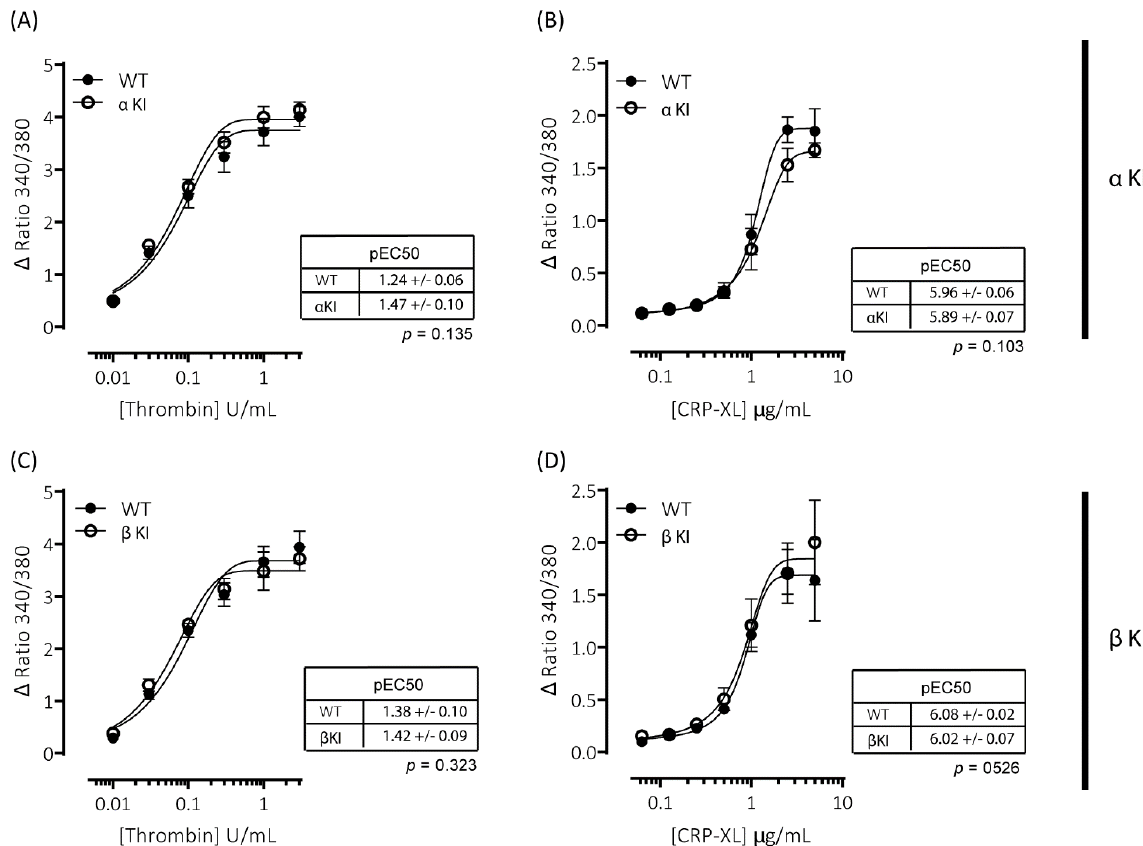
Figure 4. Intracellular Ca 2+ signalling is unaltered in platelets expressing phosphorylation-resistant GSK3 α or GSK3 β . Changes in intracellular [Ca 2+ ] were determined by loading platelets with the calcium indicator Fura-PE3 AM and monitoring fluorescence at 340/380 nm on an Infinite ® 200 PRO multimode reader (TECAN, Reading, UK). Platelets from α KI mice had no significant alterations in calcium mobilisation in response to ( A ) thrombin ( n = 4) or ( B ) CRP-XL ( n = 6). Platelets from β KI mice had no significant alterations in calcium mobilisation in response to ( C ) thrombin ( n = 3) or ( D ) CRP-XL ( n = 4). Data are expressed as the change (minus baseline) in ratio 340/380 nm. Curves were fitted with a four-parameter logistic equation (GraphPad Prism 7.04). pEC50 values are indicated in the tables and Student’s t -test was used to test for statistical differences ( p -value indicated in figure).